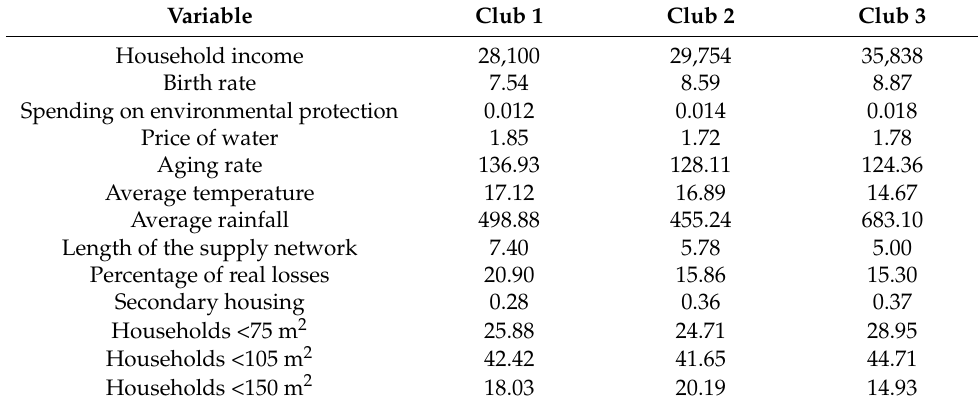
Table 3. Average values of the explanatory variables of the estimated convergence